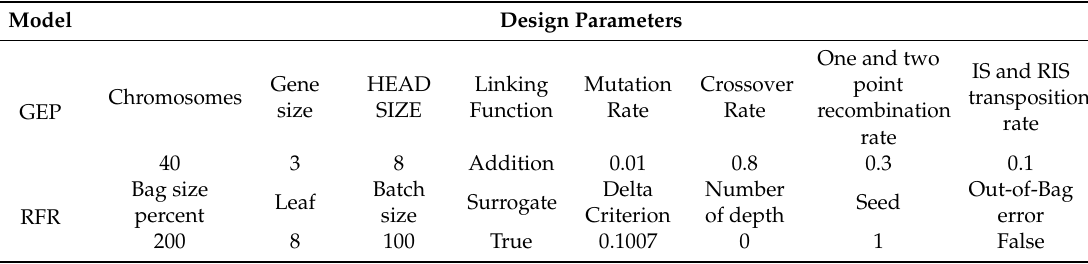
Table 4. Design parameters of gene expression programming (GEP) and random forest regression (RFR) models for calibration and validation stages at the three gauging stations.